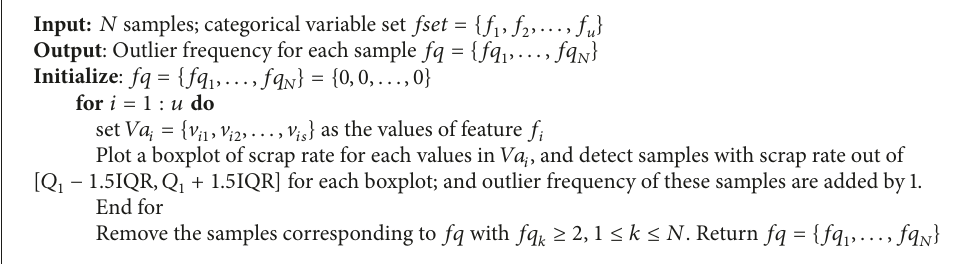
Algorithm 1: Multivariate boxplot-based outlier detection of scrap rate.